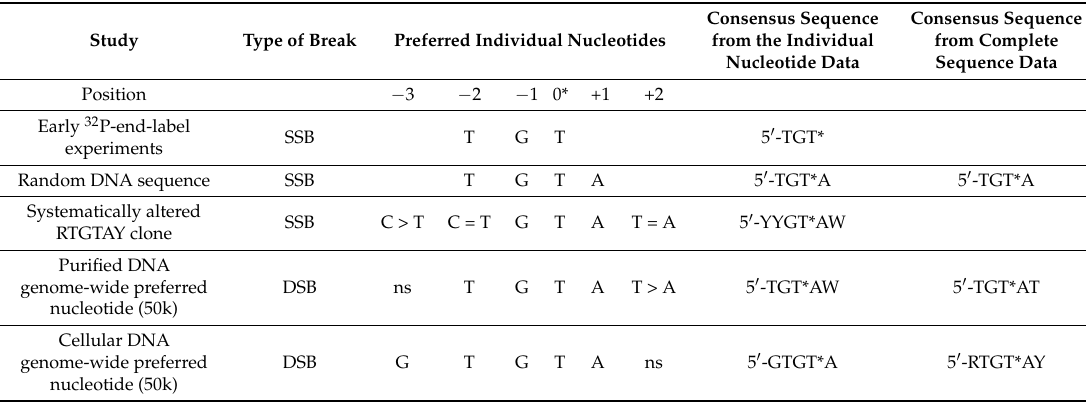
Table 1. The preferred nucleotides at the bleomycin cleavage